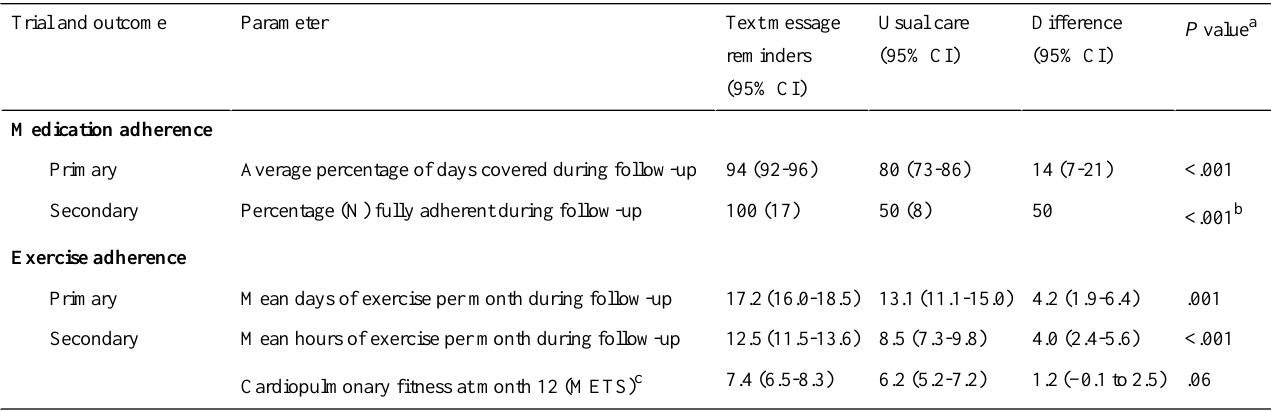
Table 2. Impact of text messaging on study outcomes.